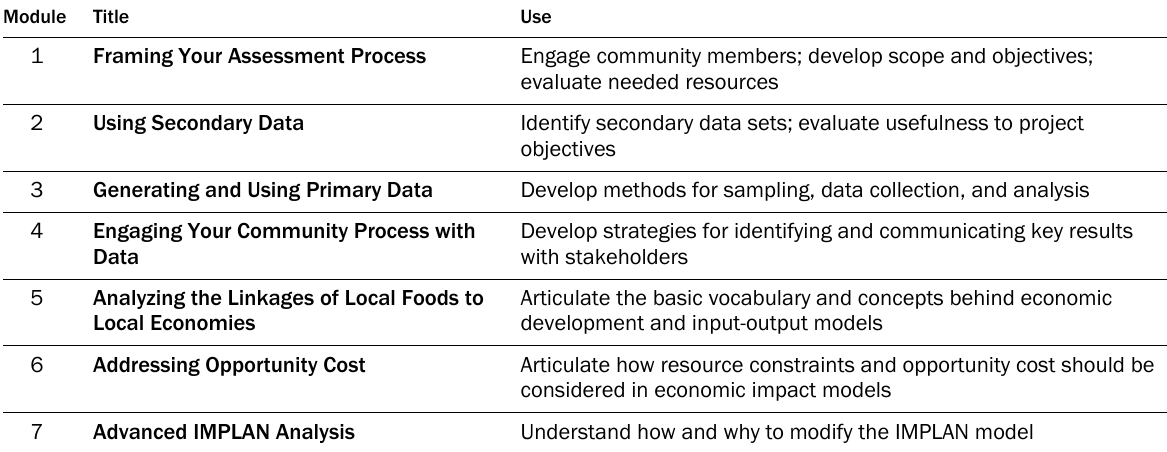
Table 1. Overview of the USDA Toolkit